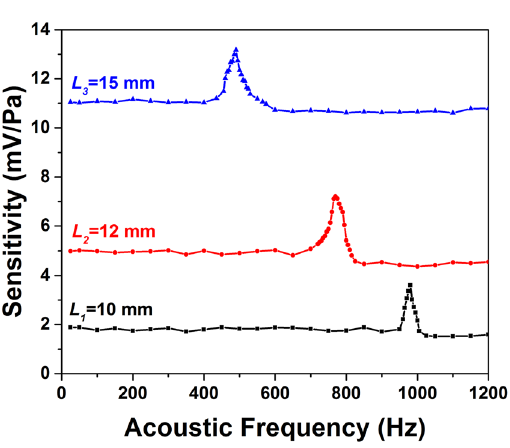
Figure 5. ( a ) Time domain and ( b ) frequency domain response for an external acoustic signal of 200 Hz, and ( c ) output voltage of the photodetector in the absence of acoustic signal, for the three MCMs with different cantilever lengths.